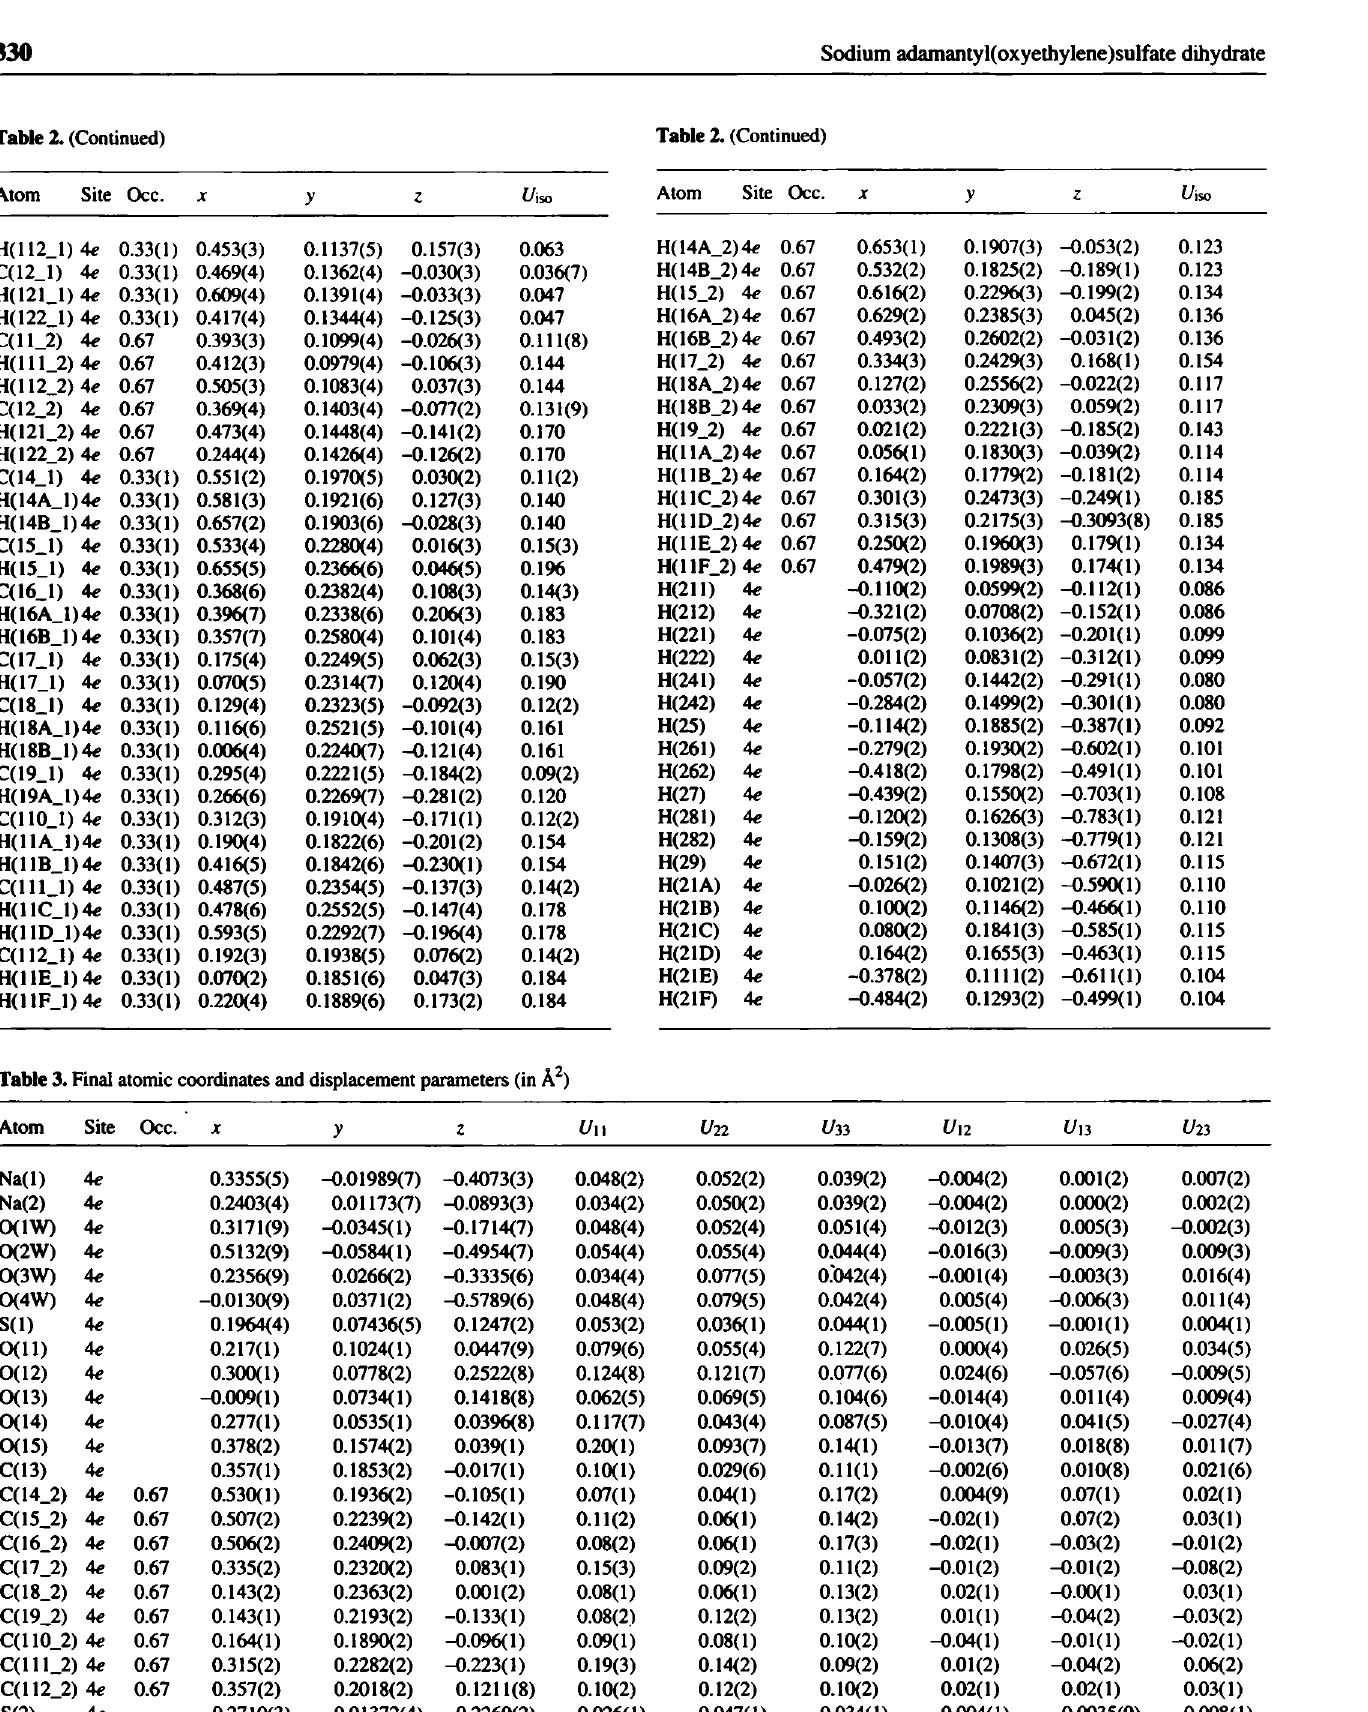
Table 3. Final atomic coordinates and displacement parameters (in Â 2